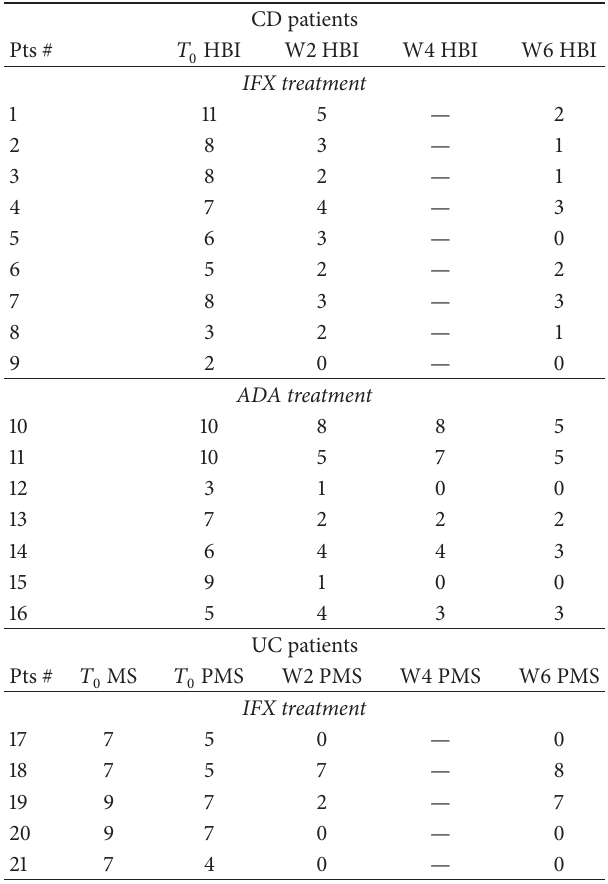
Table 2: Patients’ clinical scores. CD